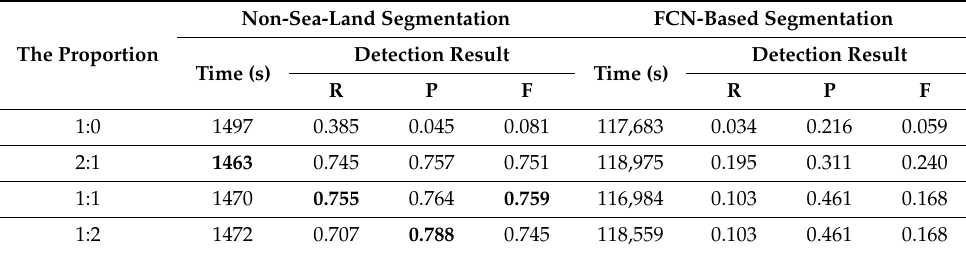
Table 5. Results and time spent of detection of the GF-1 image.